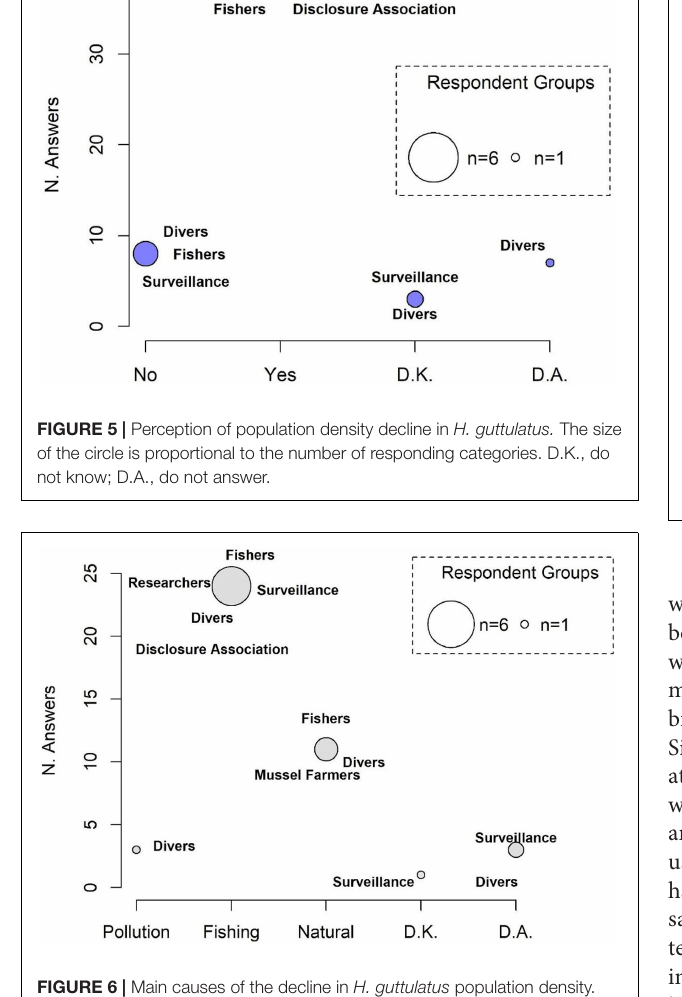
FIGURE 6 | Main causes of the decline in H. guttulatus population density. The size of the circle is proportional to the number of responding categories. D.K., do not know; D.A., do not answer.